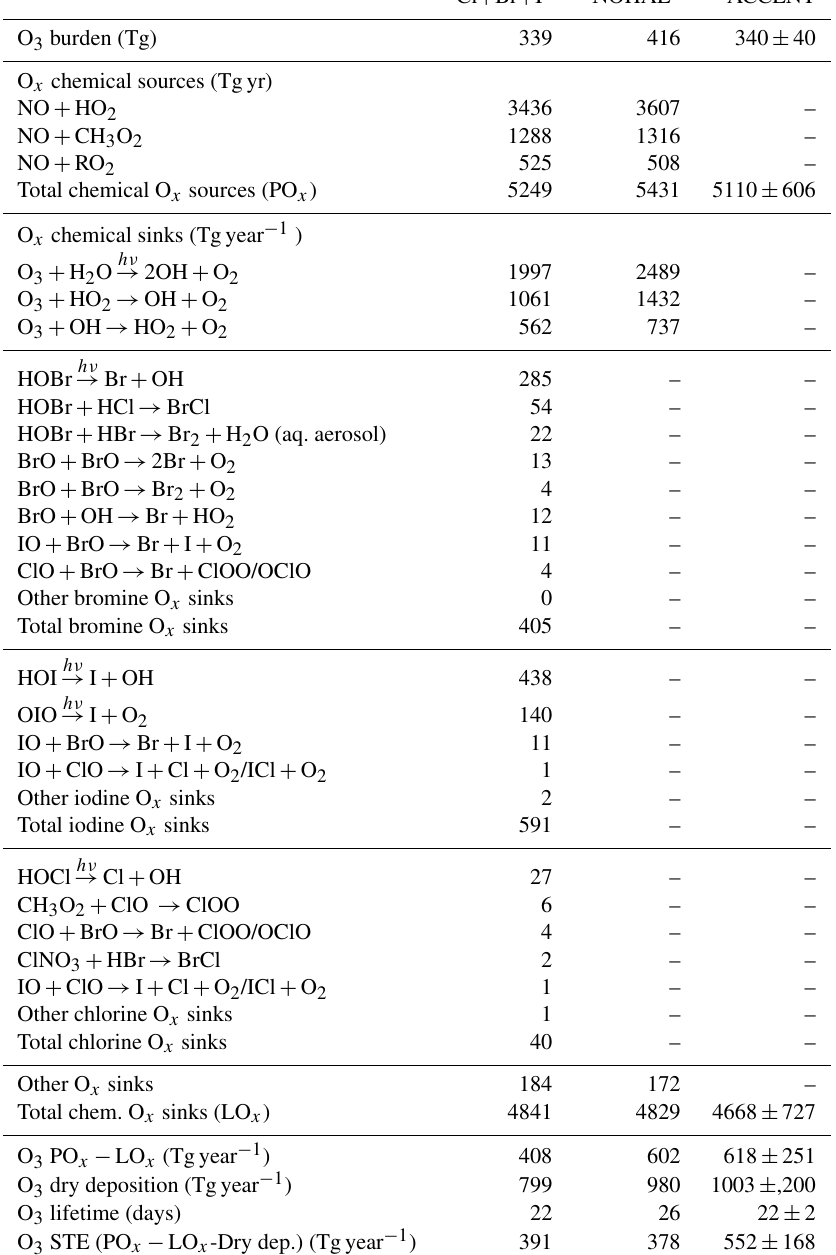
Table 4. Comparison between global tropospheric O x budgets of simulations “Cl + Br + I” (with halogen chemistry) and “NOHAL” (without halogen chemistry). Recent average model values from ACCENT (Young et al., 2013) are also shown for comparison. For the X 1 O + X 2 O halogen crossover reactions where X 1 O (cid:54)= X 2 O, we split the O 3 loss equally between the two routes. Values are rounded to the nearest integer